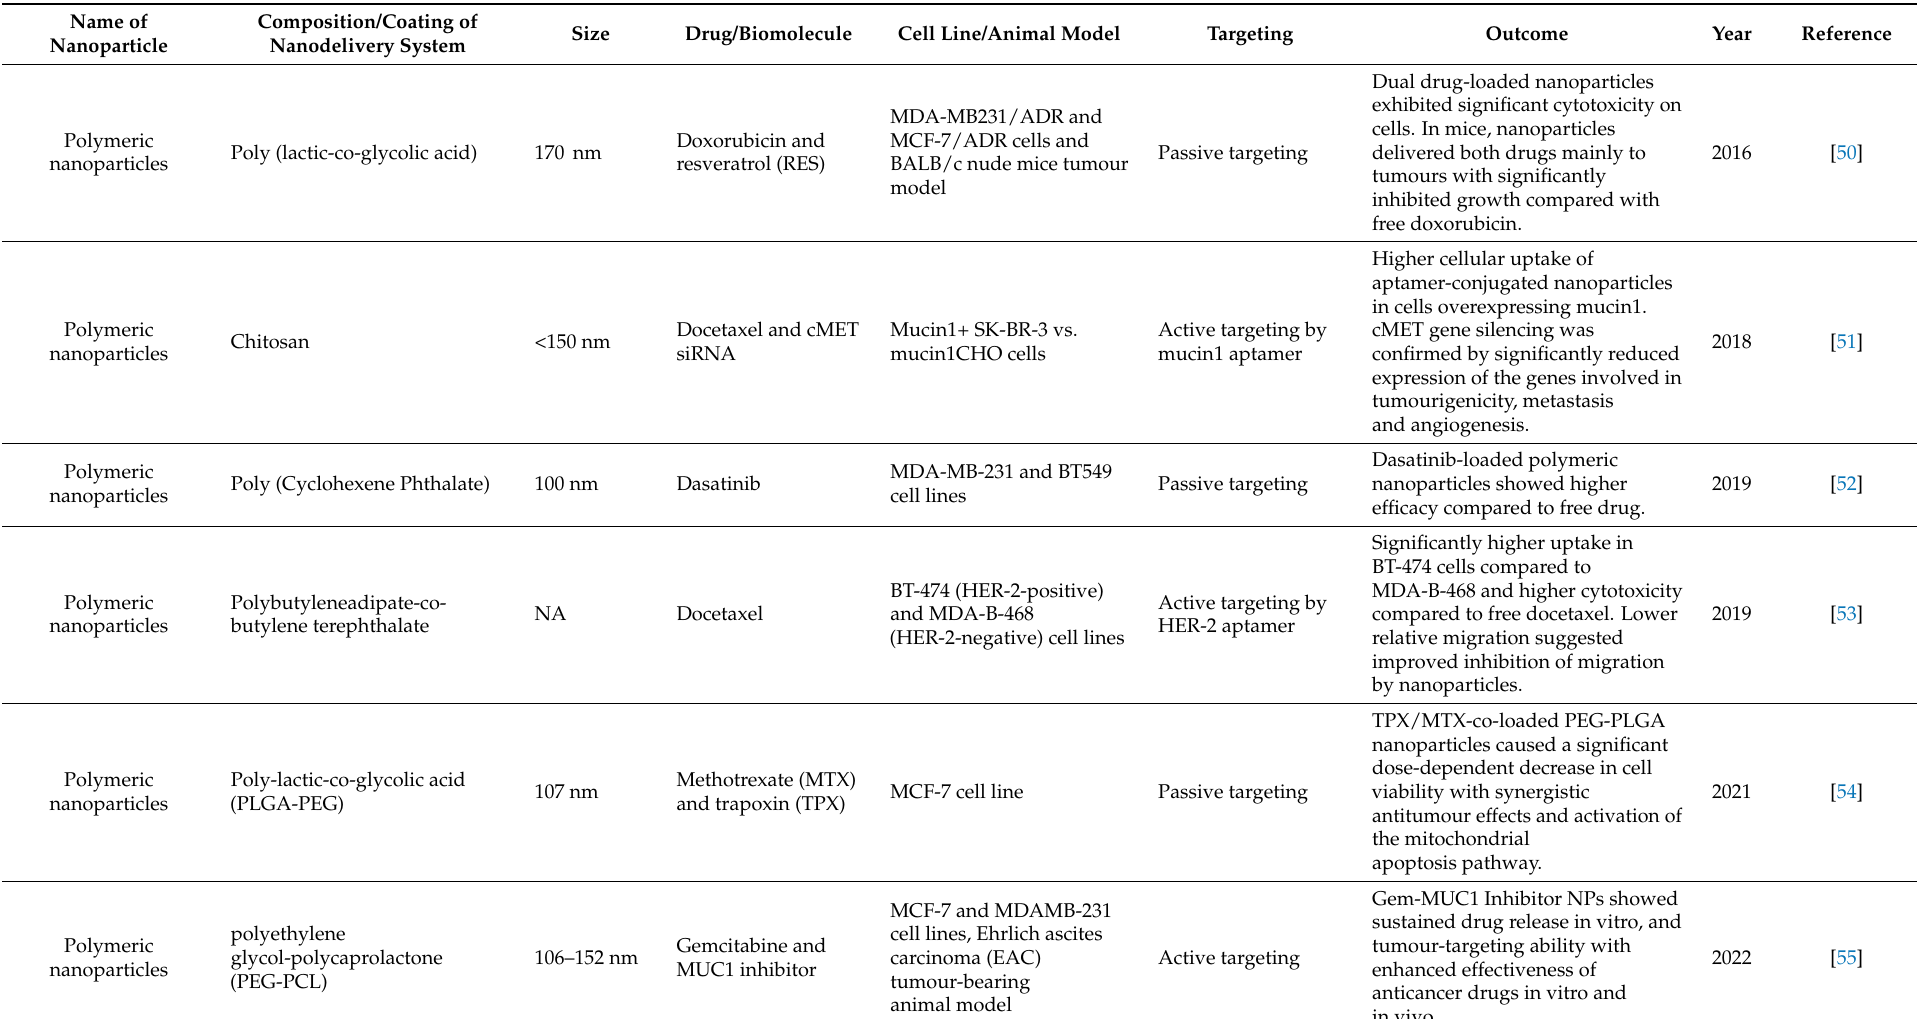
Table 2. Polymer-based nanoparticles investigated in breast